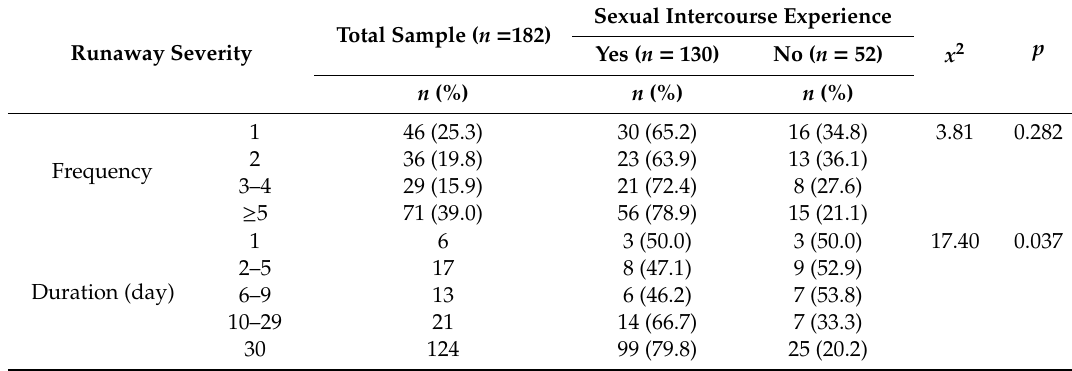
Table 2. Sexual intercourse experience based on runaway frequency and duration ( N = 182).